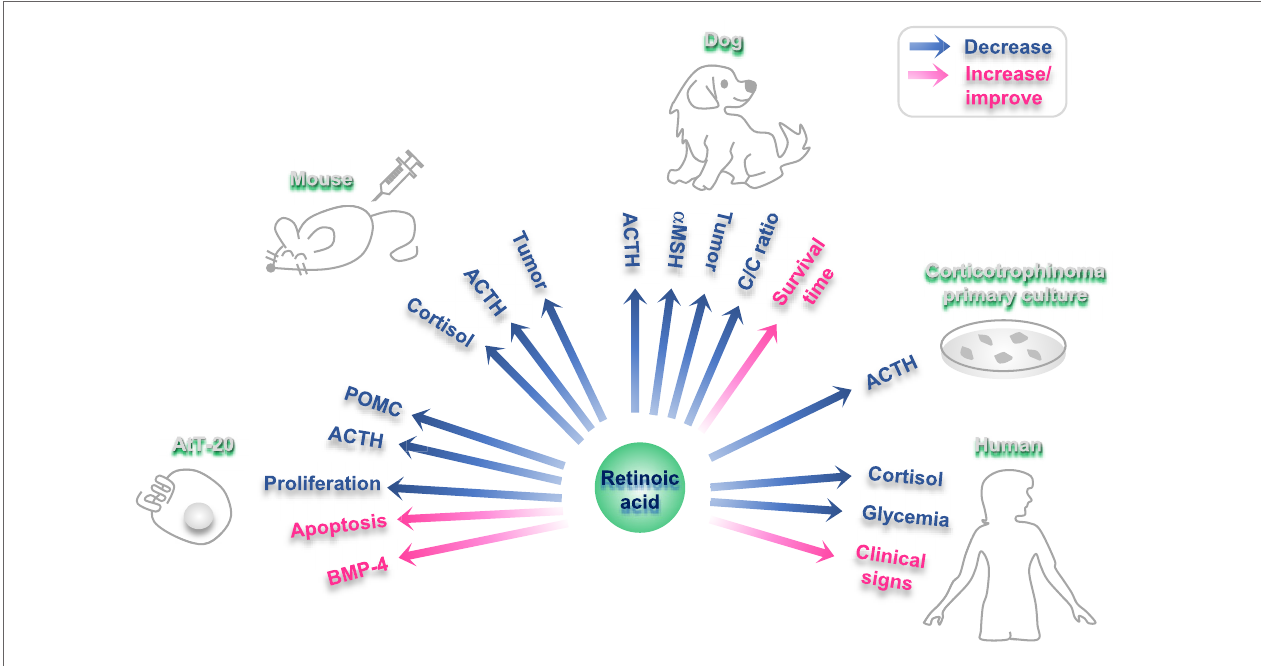
FiGURe 2 | Effects of retinoic acid (RA) on different experimental models of Cushing disease. Blue arrows: hormones/factors/read-outs than decrease with RA administration; fuchsia arrows: hormones/factors/read-outs than increase/improve with RA